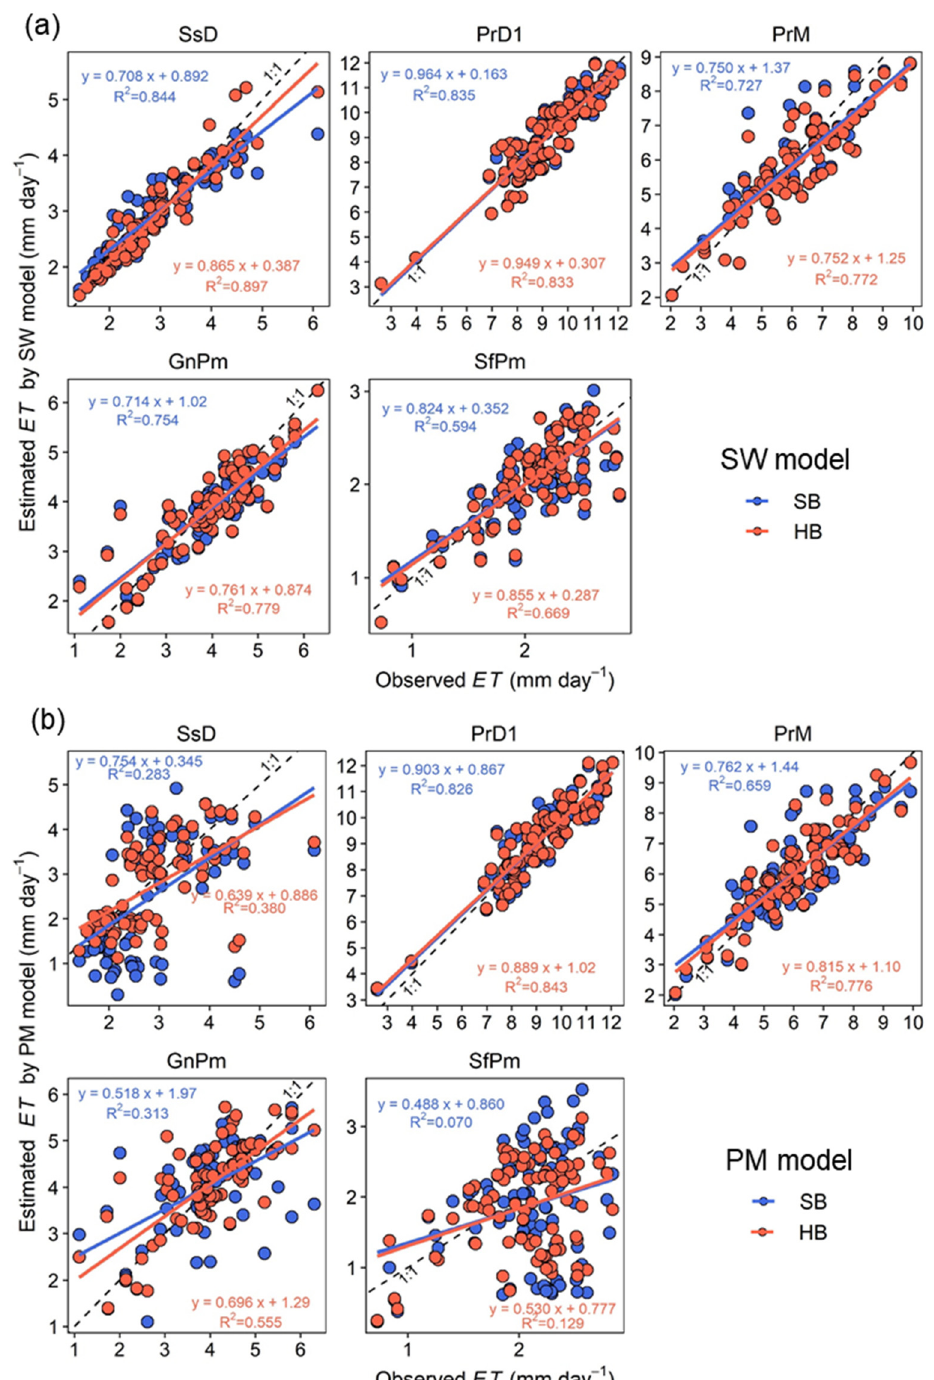
Figure 7. Regression analysis of observed and estimated evapotranspiration ( ET ) produced by ( a ) the Shuttleworth–Wallace (SW) and ( b ) the Penman–Monteith (PM) models with parameters calibrated using simple Bayesian (SB) and hierarchical Bayesian (HB) approaches at five observation conditions. R 2 , coefficient of determination.